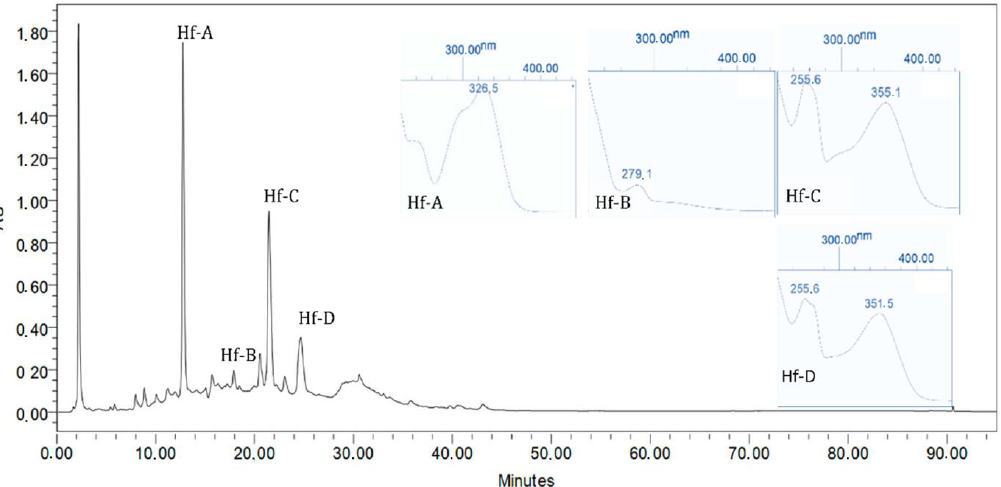
Figure 6. Hypericum foliosum DCM-MeOH extract maxplot ( λ = 190 – 450 nm) chromatogram.